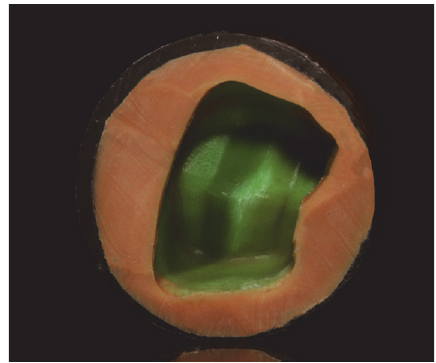
Figure 2: Film capture with light silicone of another color.